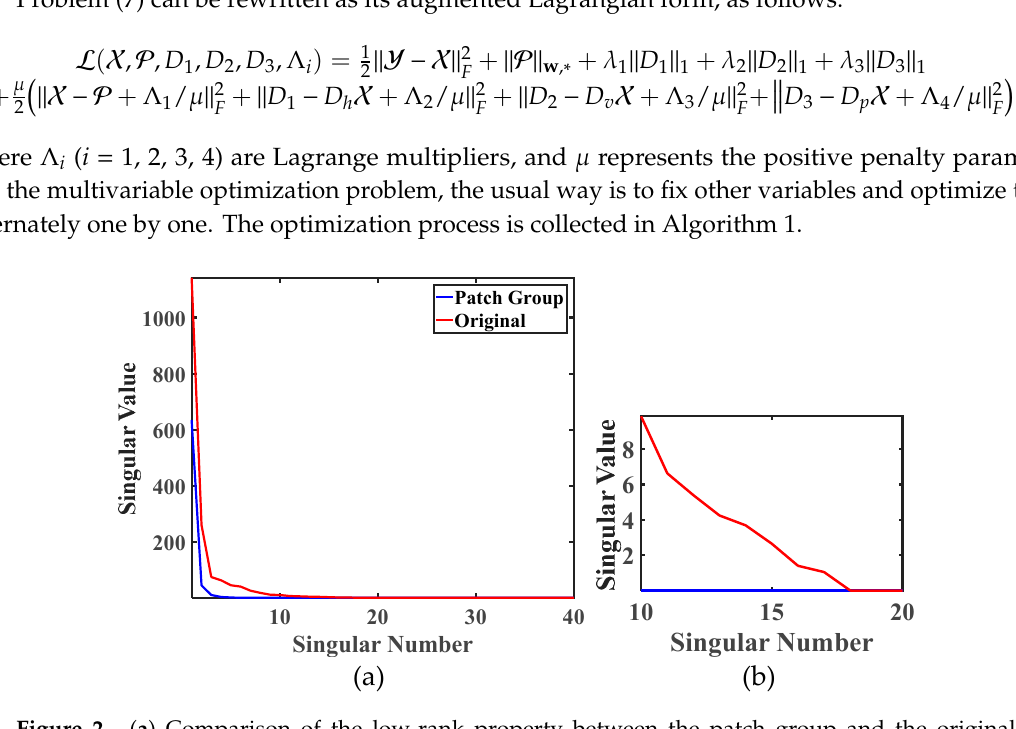
Figure 2. ( a ) Comparison of the low-rank property between the patch group and the original hyperspectral image (HSI). ( b ) Zoomed-in comparison of ( a ) when the singular number is between 10 and 20. Algorithm 1 Optimization Process for Proposed